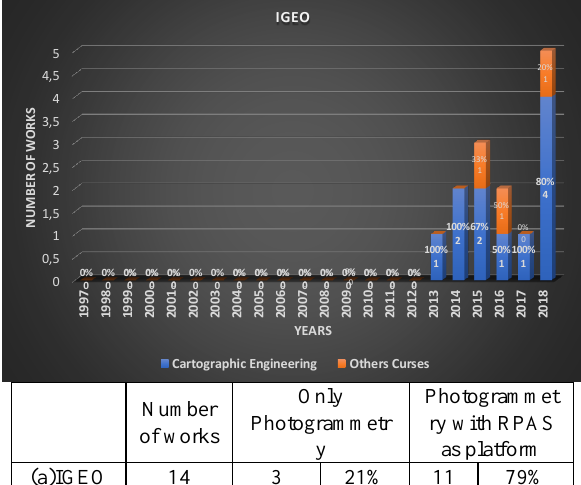
Figure 5. Works that develop or apply Photogrammetry using RPAS as one of the acquisition platforms: Cartographic Engineering x Other